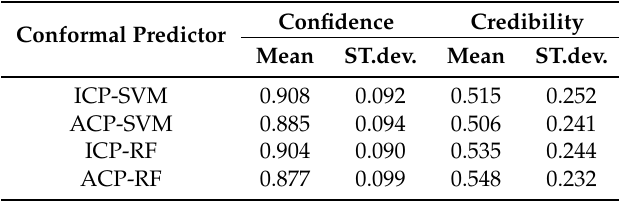
Table 5. The overall levels of confidence and credibility using different conformal